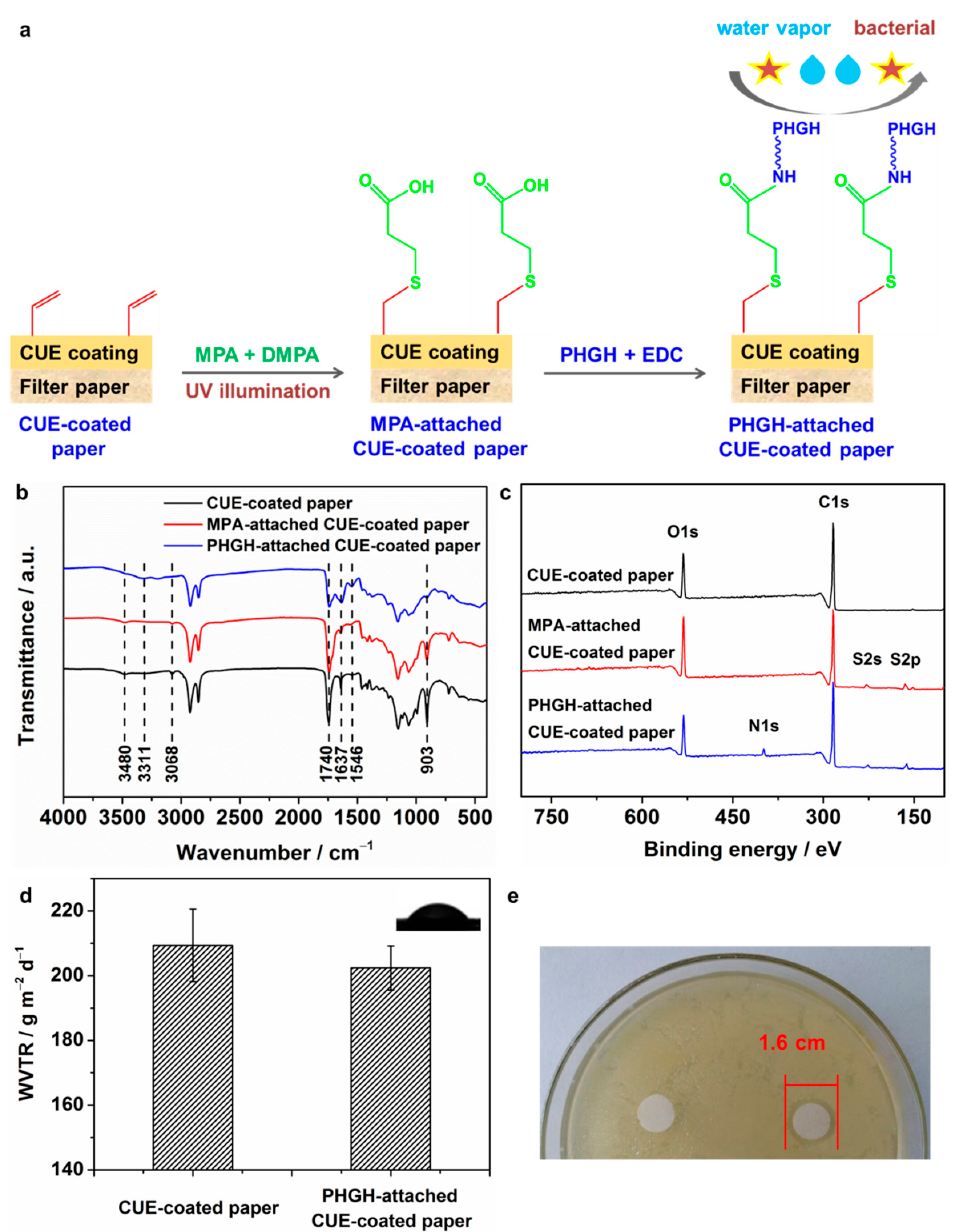
Figure 8. ( a ) Schematic illustration of the preparation of PHGH-attched CUE-coated paper; ( b ) FTIR spectra of CUE-coated paper (CUE 11.62 -coated paper), MPA-attached CUE-coated paper, and PHGH-attached CUE-coated paper; ( c ) XPS spectra of CUE-coated paper, MPA-attached CUE-coated paper, and PHGH-attached CUE-coated paper; ( d ) WVTR value of CUE-coated paper (CUE 11.62 -coated paper) and PHGH-attached CUE-coated paper with inserted contact angle image of PHGH-attached CUE-coated paper; and ( e ) Antibacterial property of CUE 11.62 -coated paper and PHGH-attached CUE-coated paper.